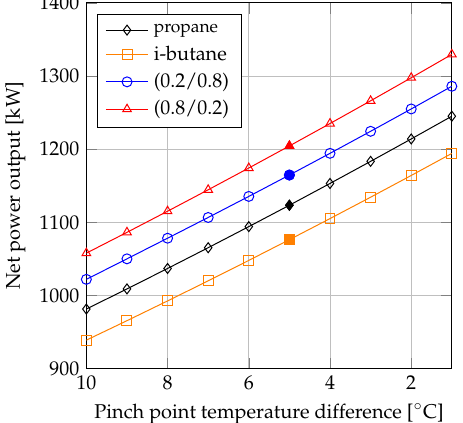
Figure 3. Net power output versus pinch point temperature difference for the condenser.